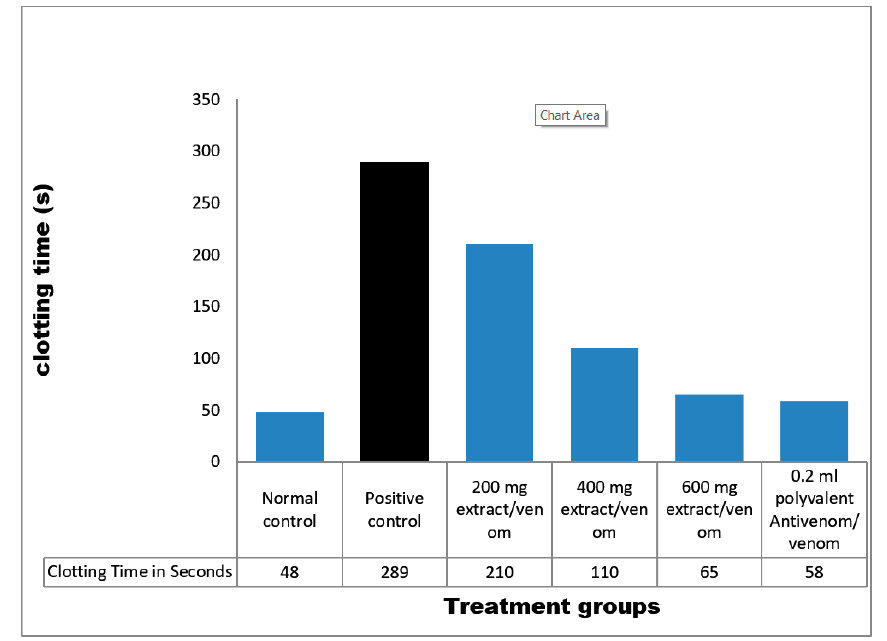
Figure 5. Coagulant activity of M. oleifera extract against E. ocellatus venom. Data are expressed as means ± S.D. of three individual experiments ( n = 3). Group 1: distilled water/citrated plasma (normal control), Group 2: venom/citrated plasma (venom control), Group 3: venom/citrated plasma/100 mg/kg extract, Group 4: venom/citrated plasma/200 mg/kg extract, Group 5: venom/citrated plasma/300 mg/kg extract, Group 6: venom/citrated plasma/0.2 mL polyvalent anti- venom.